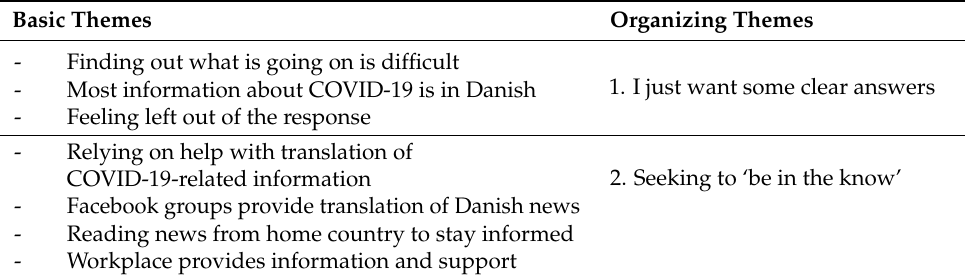
Table 2. Thematic network